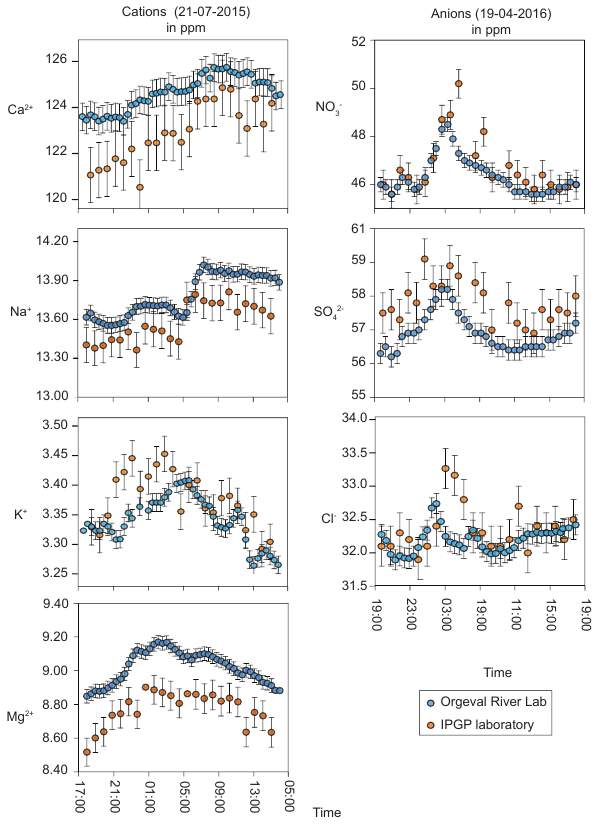
Figure 4. Reproducibility assessment of IC measurements made by the RL every 40min (blue), compared with concentration mea- surements made in the laboratory after conventional hourly river sampling (orange). Tests were performed on 21 July 2015 and 19 April 2016 for the cationic and ionic species respectively. For measurements performed in the laboratory, the error measurement is 1% (except for K + at 2%), calculated as the standard deviation over repeated injection of the standard solutions “River × 1”. For RL measurements the error is given in Table